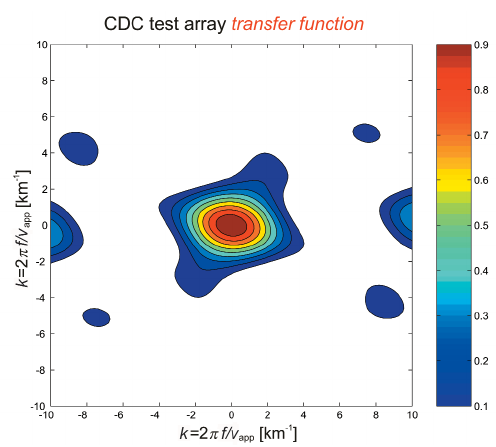
Fig. 3. Array response function of the CDC test ar- ray of fig.